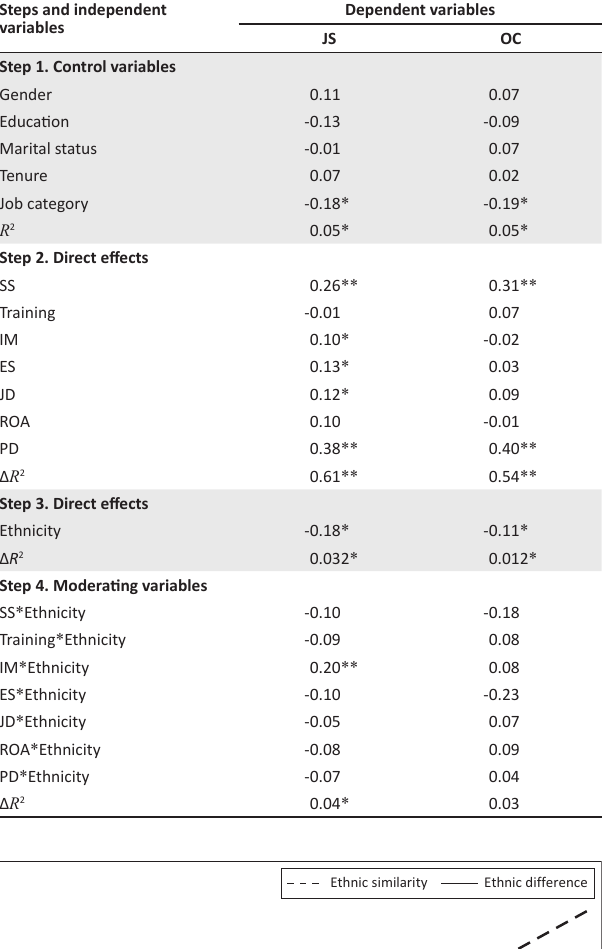
TABLE 6: Moderated hierarchical regression analysis. Steps and independent variables